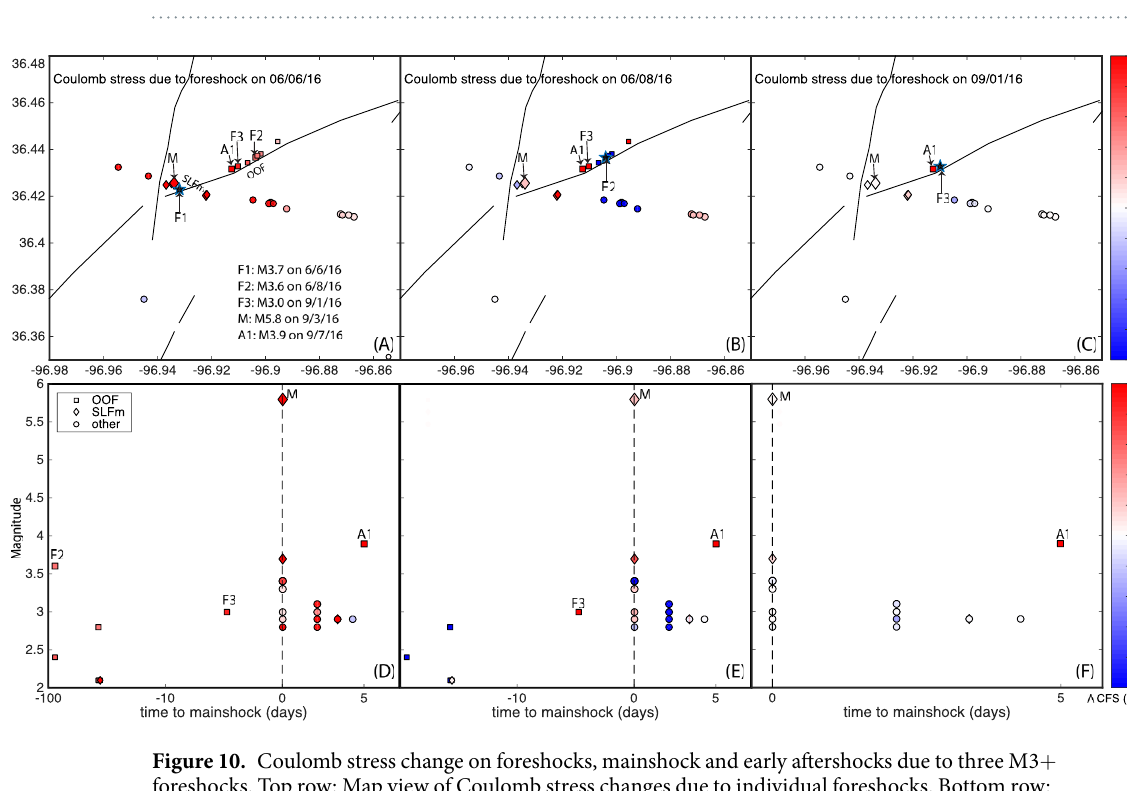
Figure 9. Source parameter inversion for the mainshock. ( a ) Waveform fitting in the CAP inversion. The black and red traces are observed and synthetic velocity seismograms, respectively. ( b ) Waveform misfit versus centroid depth. The number above the small beach ball is the moment magnitude. Stations used in the inversion are indicated as dots on the large beach ball. Red line in the beachball indicates the preferred nodal plane, and the arrow indicates preferred rupture direction. ( c ) Observed (dots) and best-fitting (lines) azimuthal variation of the time shifts for Rayleigh wave (top) and Love wave (bottom). Blue and red dots indicate observed time shift without and with calibrations of a reference event, respectively. The curves show the predicted time shifts with rupture along the nodal plane with a strike of 107°. The figures are generated from GMT, which is an open source software available at: http://gmt.soest.hawaii.edu.